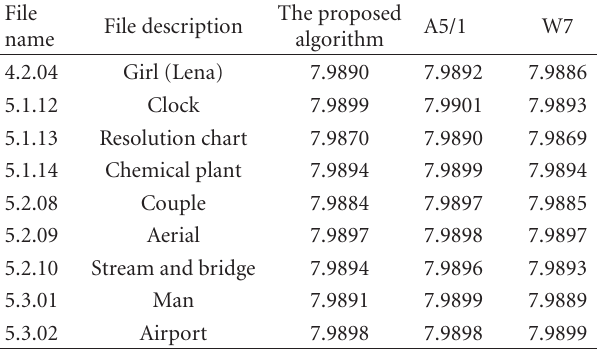
Table 1: Entropy results of encrypted images. Grayscale type with 256 × 256